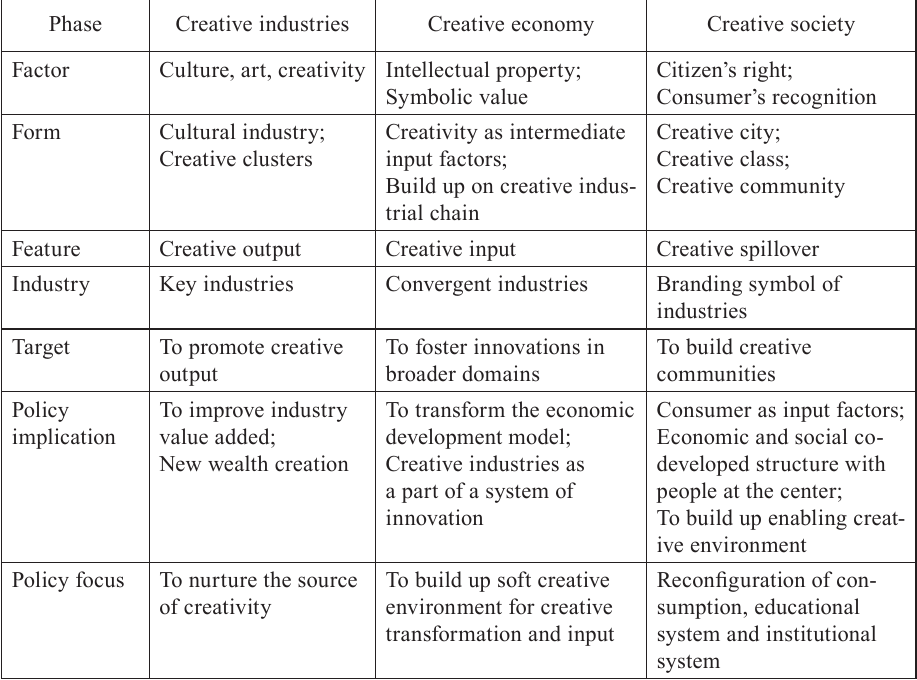
table 2. Evolution of creative